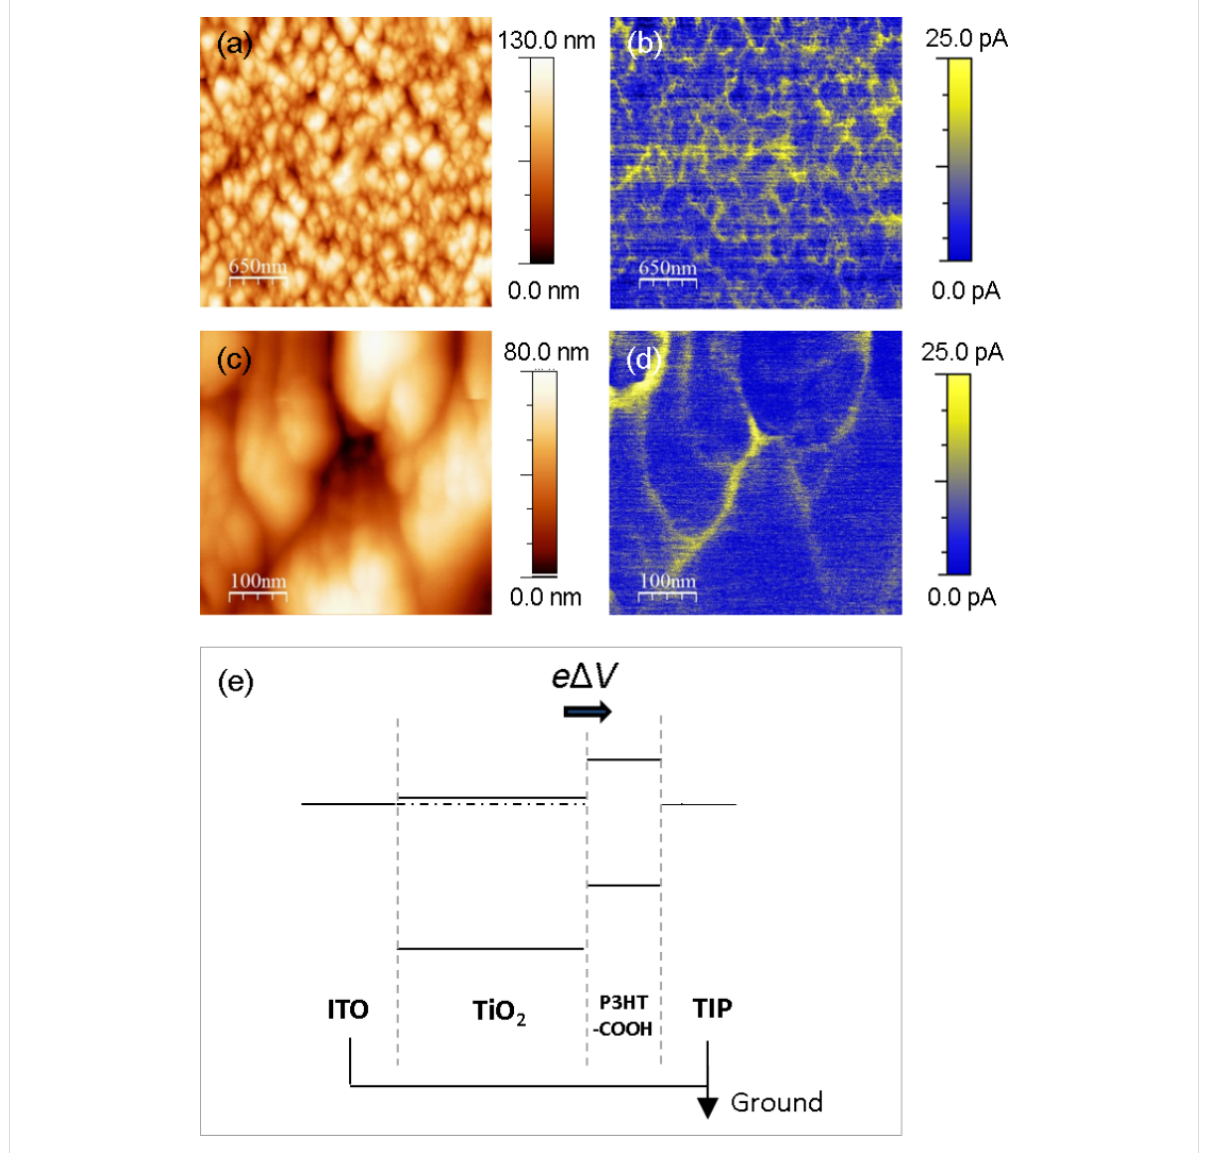
Figure 6: 5 × 5 µm 2 (a,b) and 500 × 500 nm 2 (c,d) PC-AFM height and photocurrent images of a TiO 2 /P3HT-COOH HHJ. The images were recorded upon calibrated illumination (AM 1.5, 100 suns), in short-circuit configuration. (e) Schematic representation of the electronic band structure of the ITO/ TiO 2 /P3HT-COOH/tip system in short-circuit configuration. e Δ V corresponds to the bond